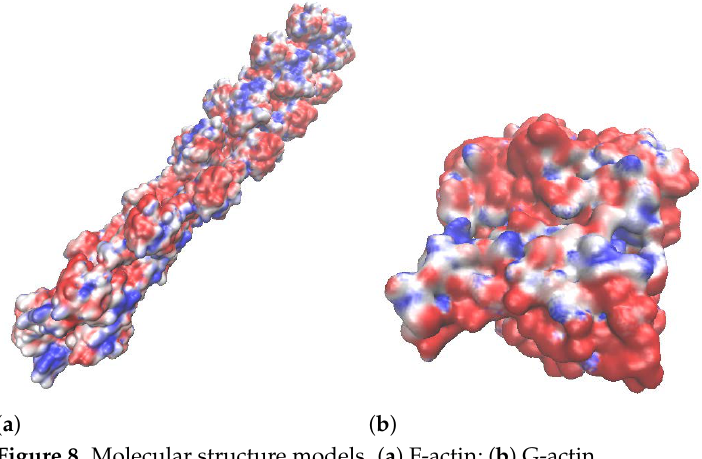
Figure 8. Molecular structure models. ( a ) F-actin; ( b )